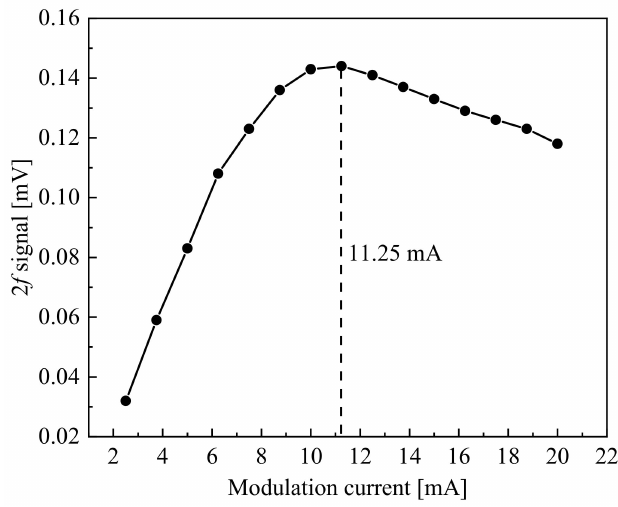
Figure 5. The 2 f signal of CH 4 under different modulation